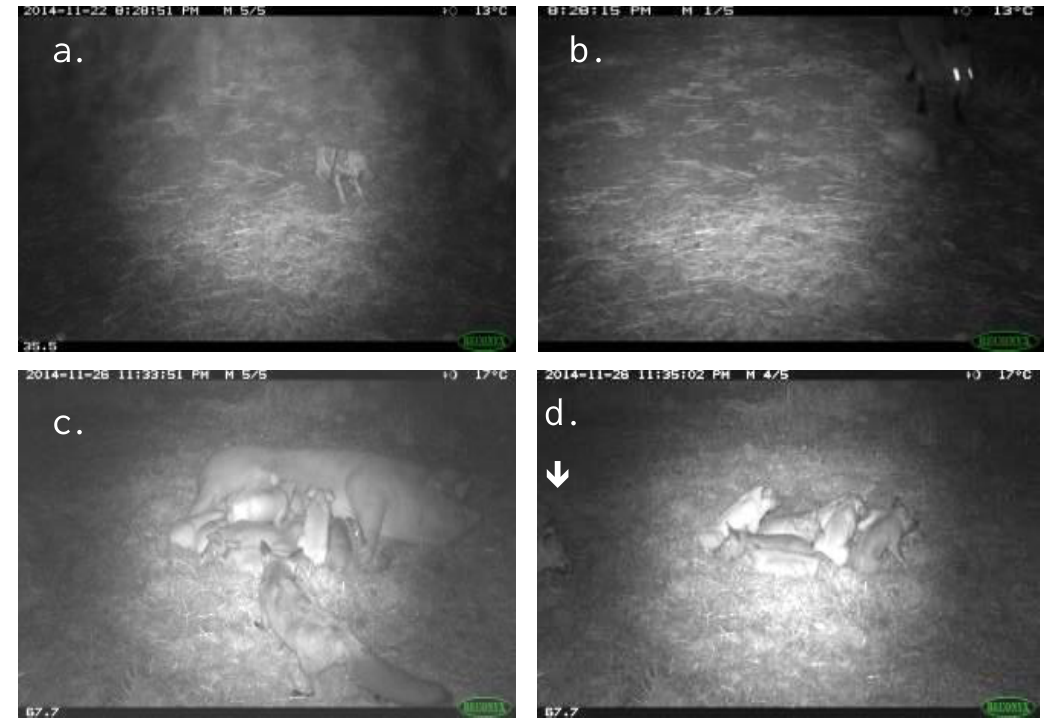
Figure 3. Photos of fox interaction with piglets. (a) A newborn piglet (umbilical cord and embryonic membrane still present) born outside of the farrowing hut and (b) fox taking the piglet; (c) fox taking a 2–3-week-old piglet from a sow feeding outside of a farrowing hut; (d) piglets showing limited wariness towards an approaching fox (arrow).